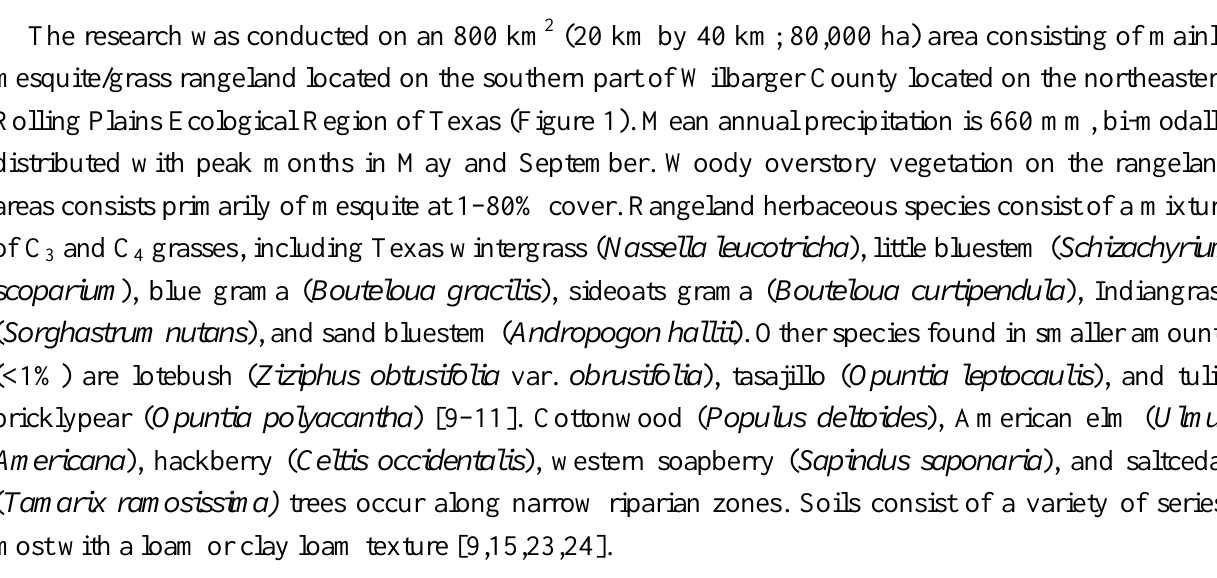
Figure 1. Maps of the United States, with the state of Texas shown in green ( a ), the state of Texas, with Wilbarger County shown in blue ( b ), and Wilbarger County, with the 800 km 2 study site shown in red ( c ). Distance scale applies to the county